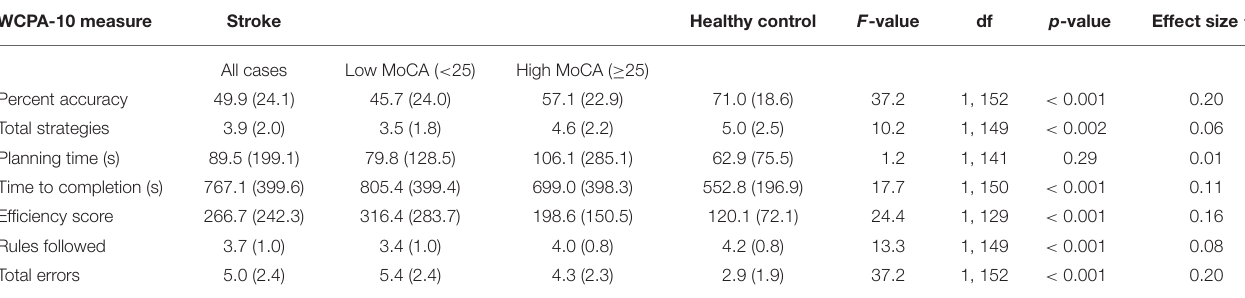
TABLE 2 | Performance of stroke and healthy participants on the WCPA-10. WCPA-10 measure Stroke Healthy control F